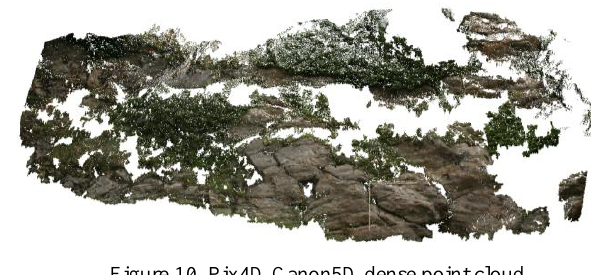
Figure 10. Pix4D Canon5D dense point cloud